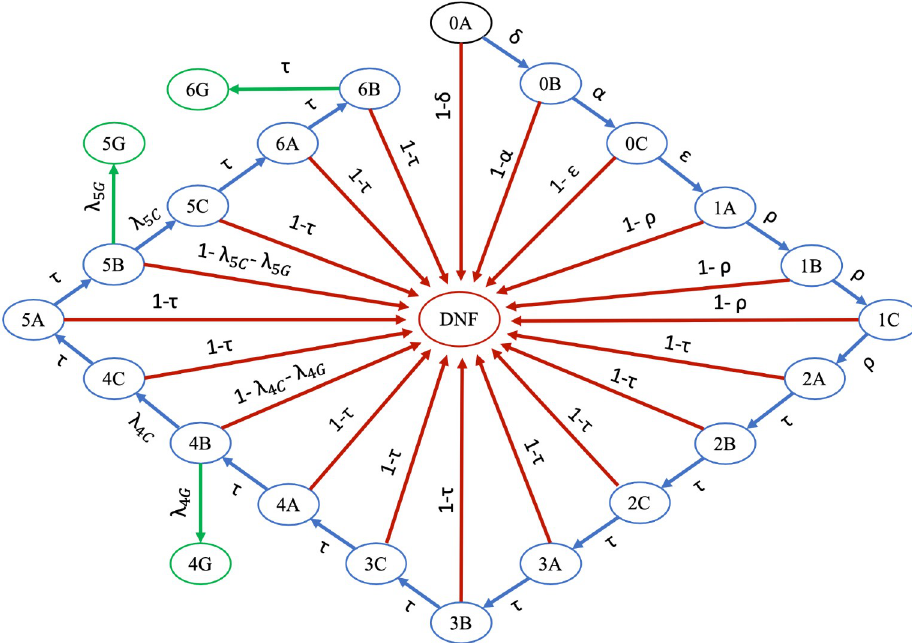
Fig 1. Markov chain model for predicting undergraduate student body demographics. To label nodes, we pair a number from zero through six to describe the academic year (where zero represents pre-college year) and a letter from the set { A , B , C , G } to correspond to the term or standing within that year. A represents the fall term, B represents the spring term, C represents the summer term (or the transition from one year to the next), and G corresponds to graduation. The state DNF represents students who did not obtain an undergraduate degree. A student begins in state 0 A and then moves through the graph according to the probabilities on each directed edge. Blue nodes represent transient states, green nodes represent the absorbing states of graduating, and red nodes represent the absorbing state of not finishing. Arrows are labeled with the transition probabilities between states.